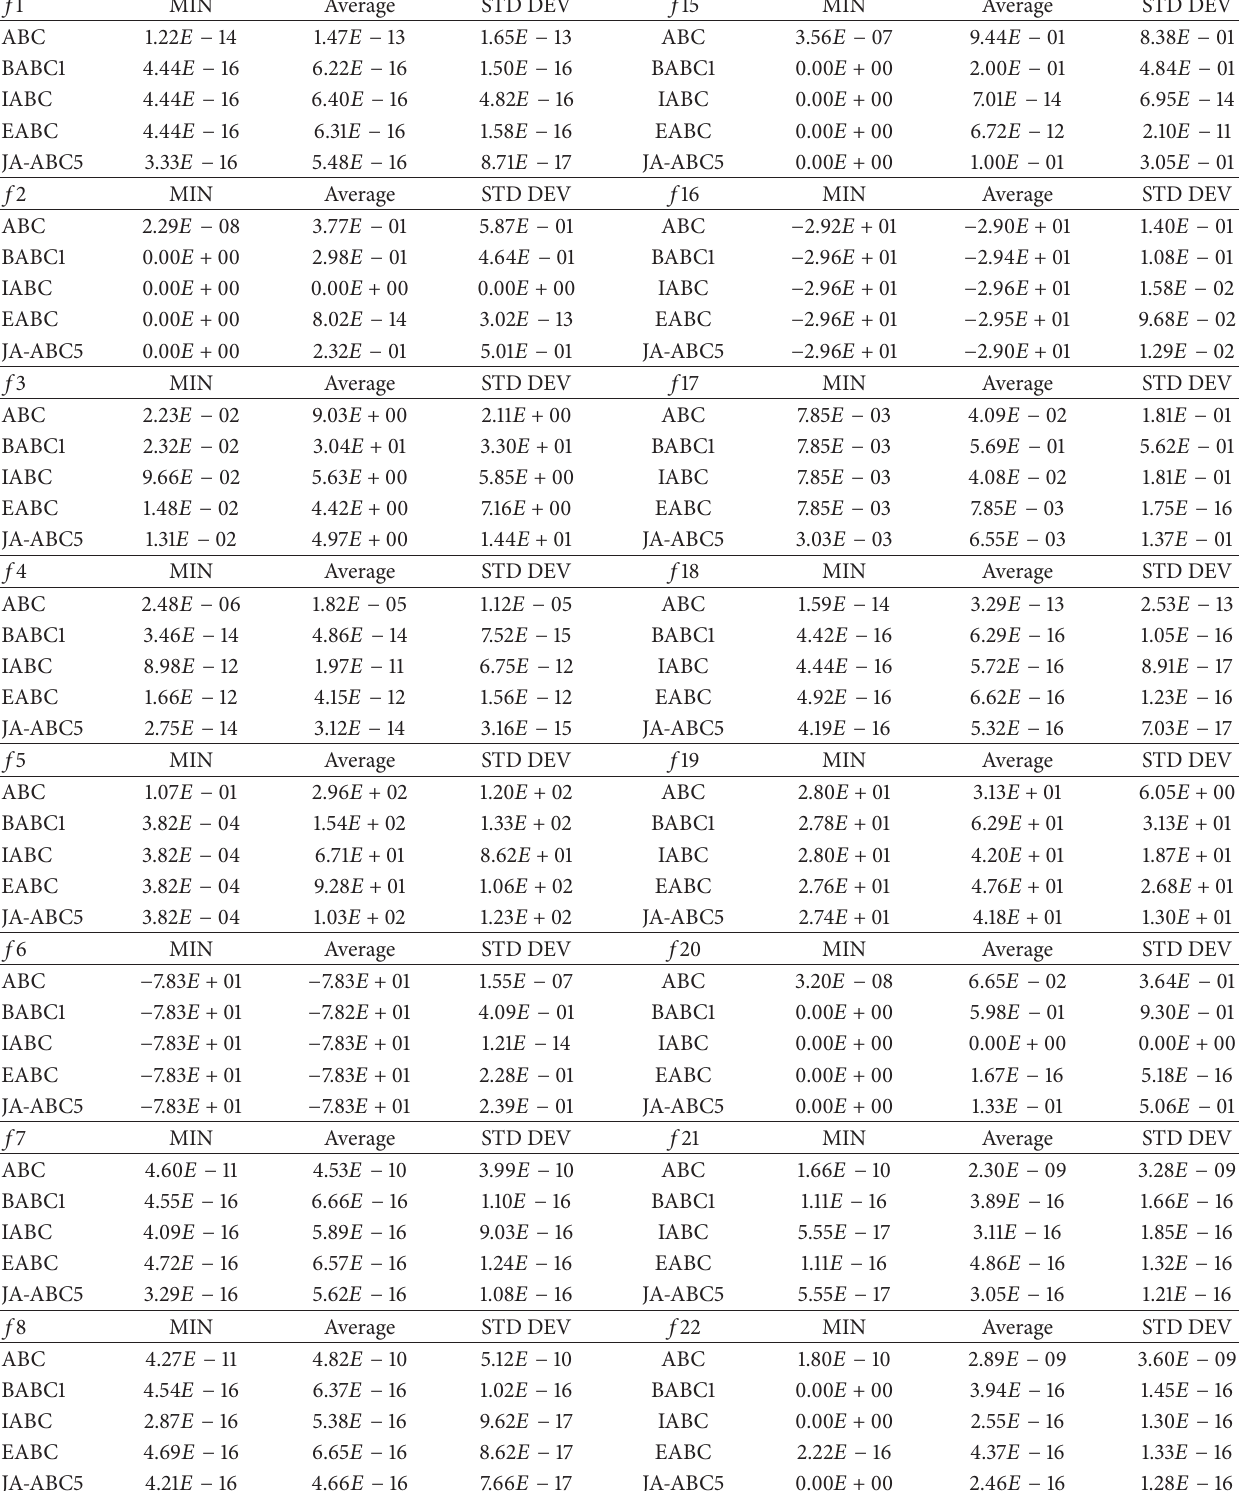
Table 2: Statistical Results of Optimization